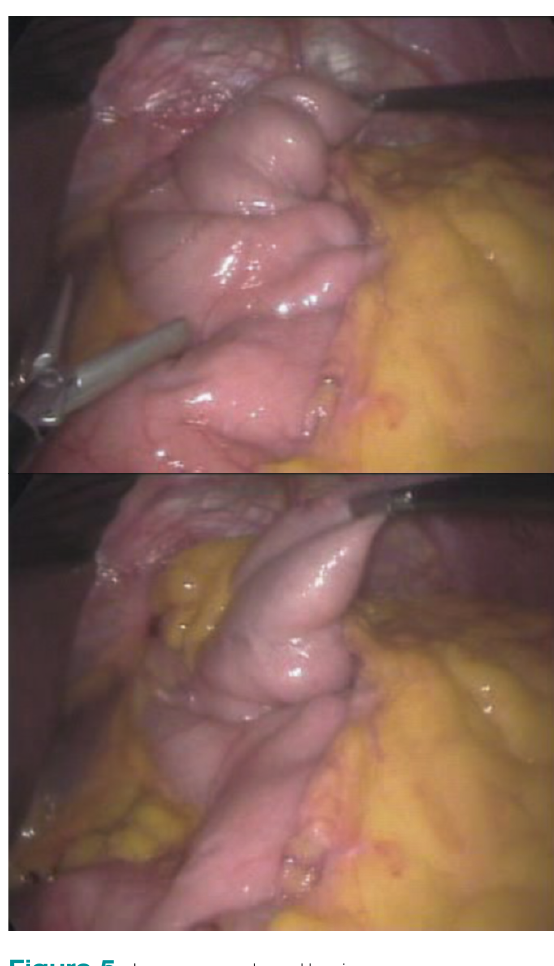
Figure 3,4. Mesenteroaxial gastric volvulus.